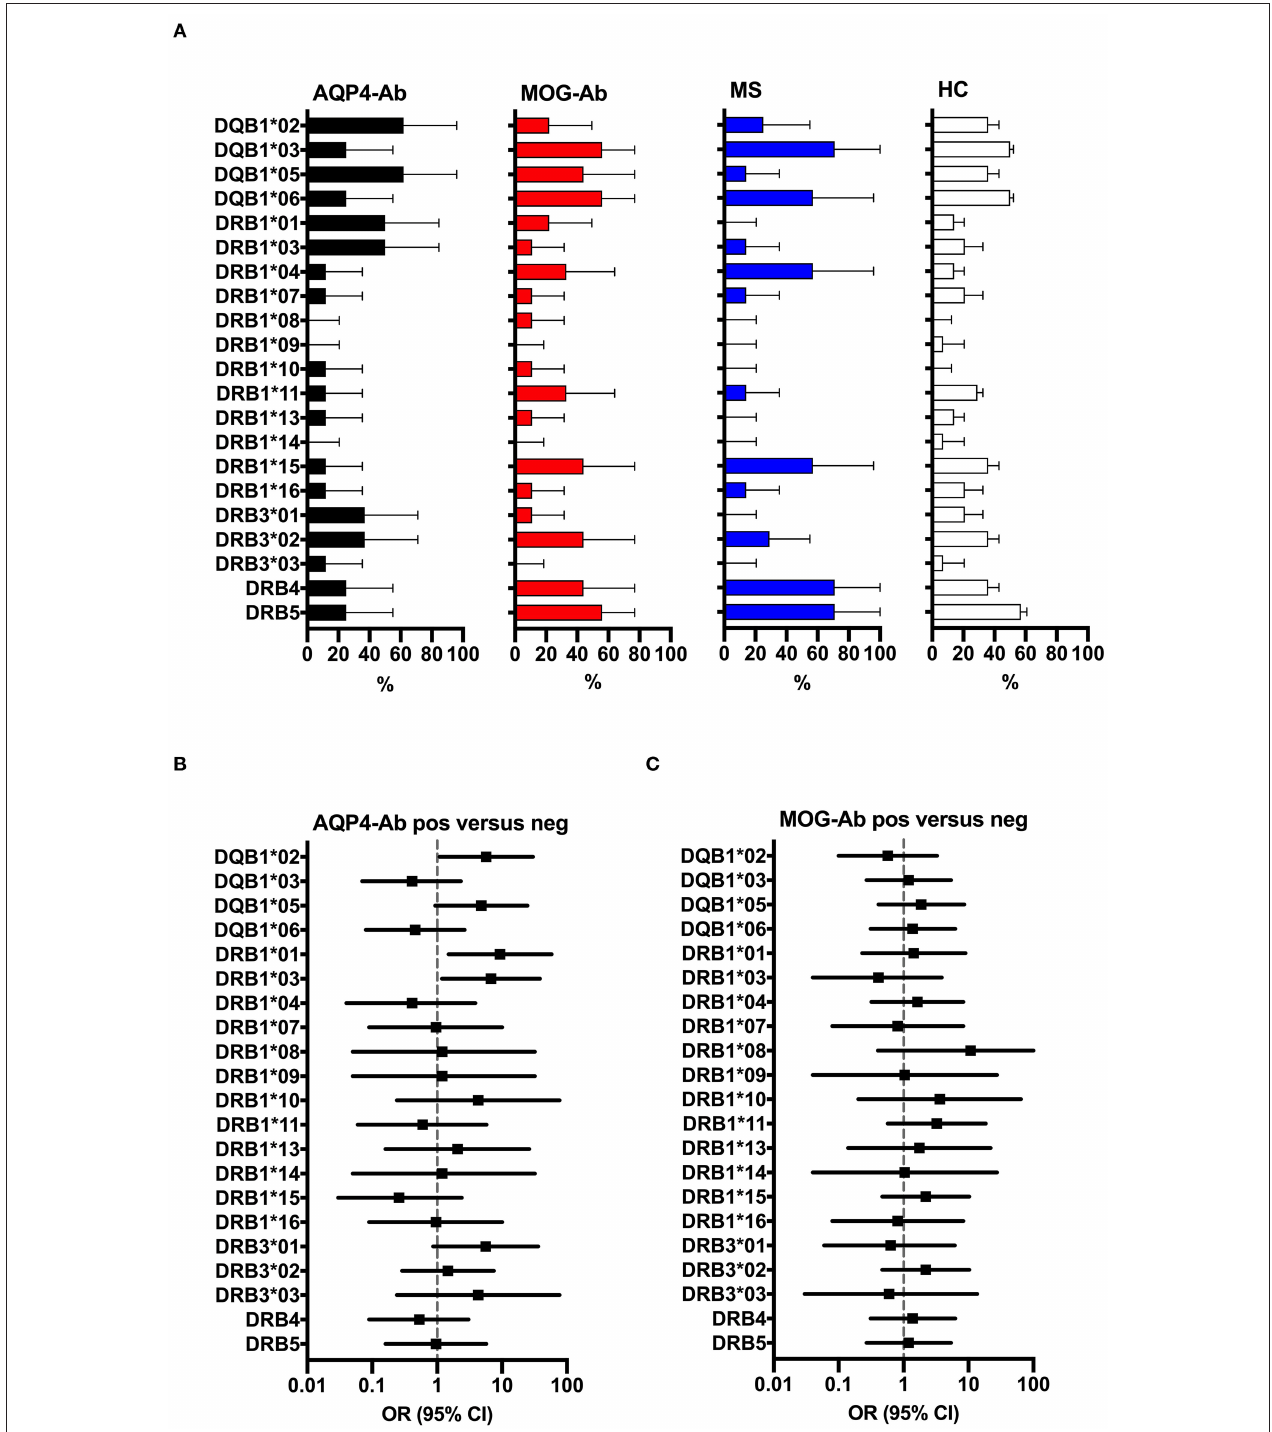
FIGURE 8 | (A) HLA allele frequency (in% with 95% confidence intervals indicated by the error bars) of participants with AQP4-Ab ( n = 8), MOG-Ab ( n = 9), MS ( n = 8) and HC ( n = 14). (B) Forest plot displaying Mantel-Haenszel common odds ratio estimates (symbols) with asymptomatic 95% CI (horizontal lines) for the different HLA alleles in participants with AQP4-Ab ( n = 8) vs. all AQP4-Ab negative participants ( n = 31). HLA alleles DQB1*02, DRB1*01 and DRB1*03 were overrepresented in participants with AQP4-Ab. (C) Forest plot displaying Mantel-Haenszel common odds ratio estimates (symbols) with asymptomatic 95% CI (horizontal lines) for the different HLA alleles in participants with MOG-Ab ( n = 9) vs. all MOG-Ab negative participants ( n = 30). AQP4-Ab, aquaporin-4 antibody positive; HC, healthy controls; HLA, human leucocyte antigen; MOG-Ab, myelin oligodendrocyte glycoprotein antibody positive; MS, multiple sclerosis.